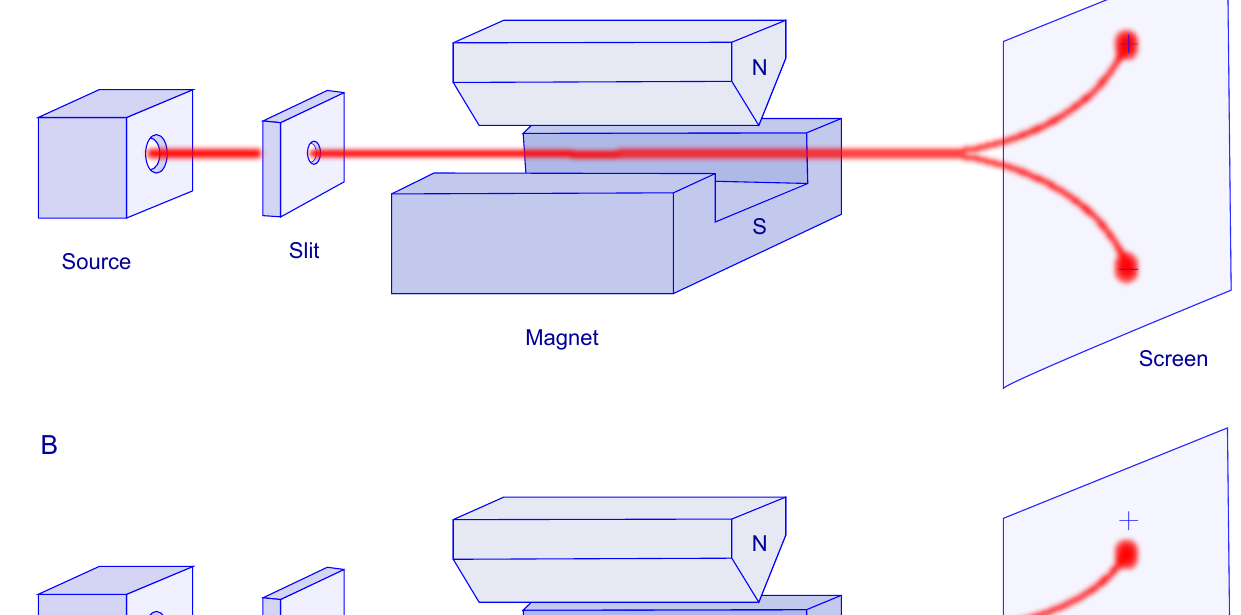
system. The source 2